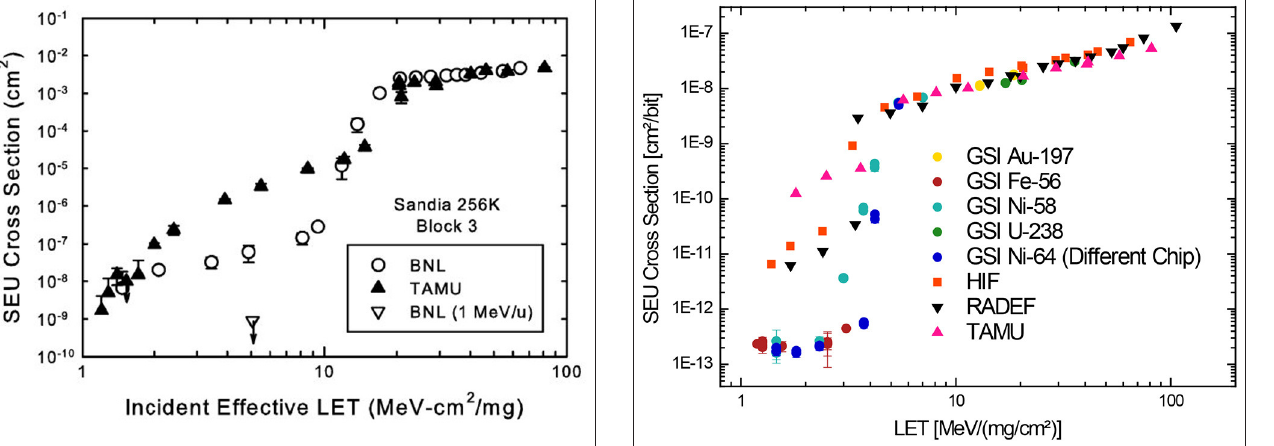
FIGURE 3 | Overview of results measured at GSI, TAMU, and RADEF